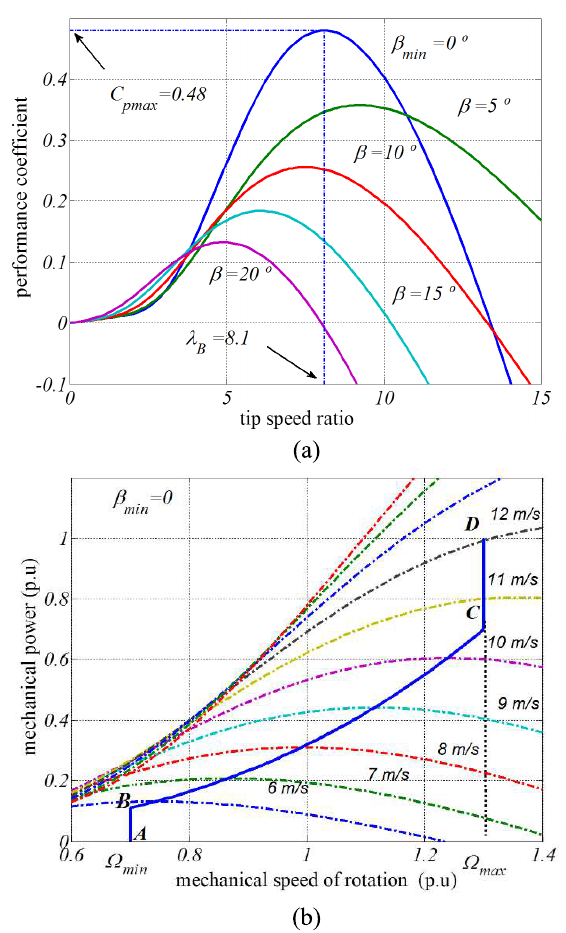
Figure 2. Graphical representation of wind turbine (WT) equations: ( a ) C p versus λ for different β values; ( b ) WT power ( p m ) for different wind speeds and maximum power loci (curve